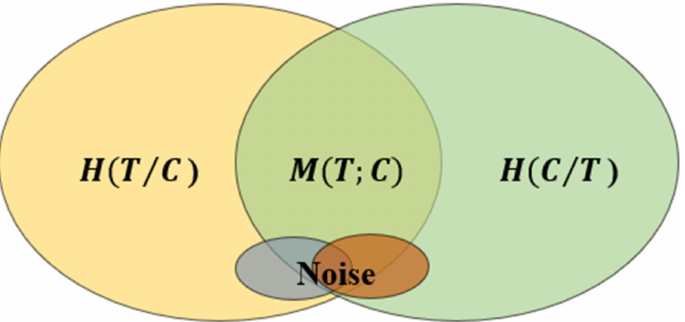
Figure 4. The relationship between noised image T and noised image C